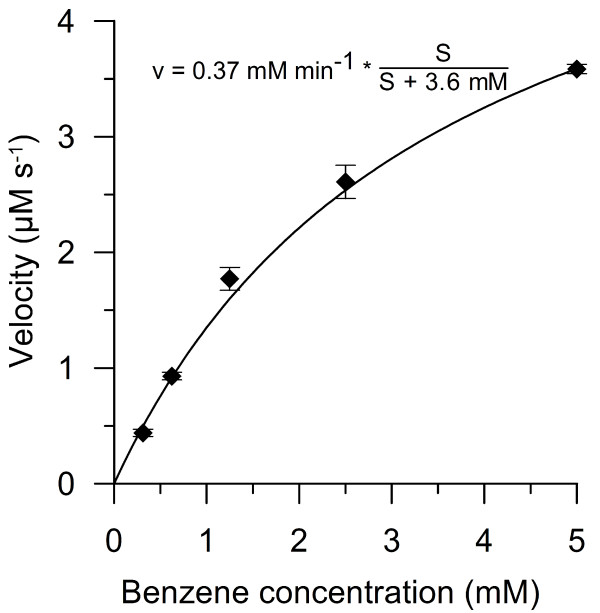
Conversion rates for benzene obtained with 0.78 μM AaeAPO in the presence of 6 mM hydrogen peroxide as a function of benzene concentration. The conversion of benzene was followed by detecting the concentrations of phenol, hydroquinone and catechol (sum of them) by HPLC.